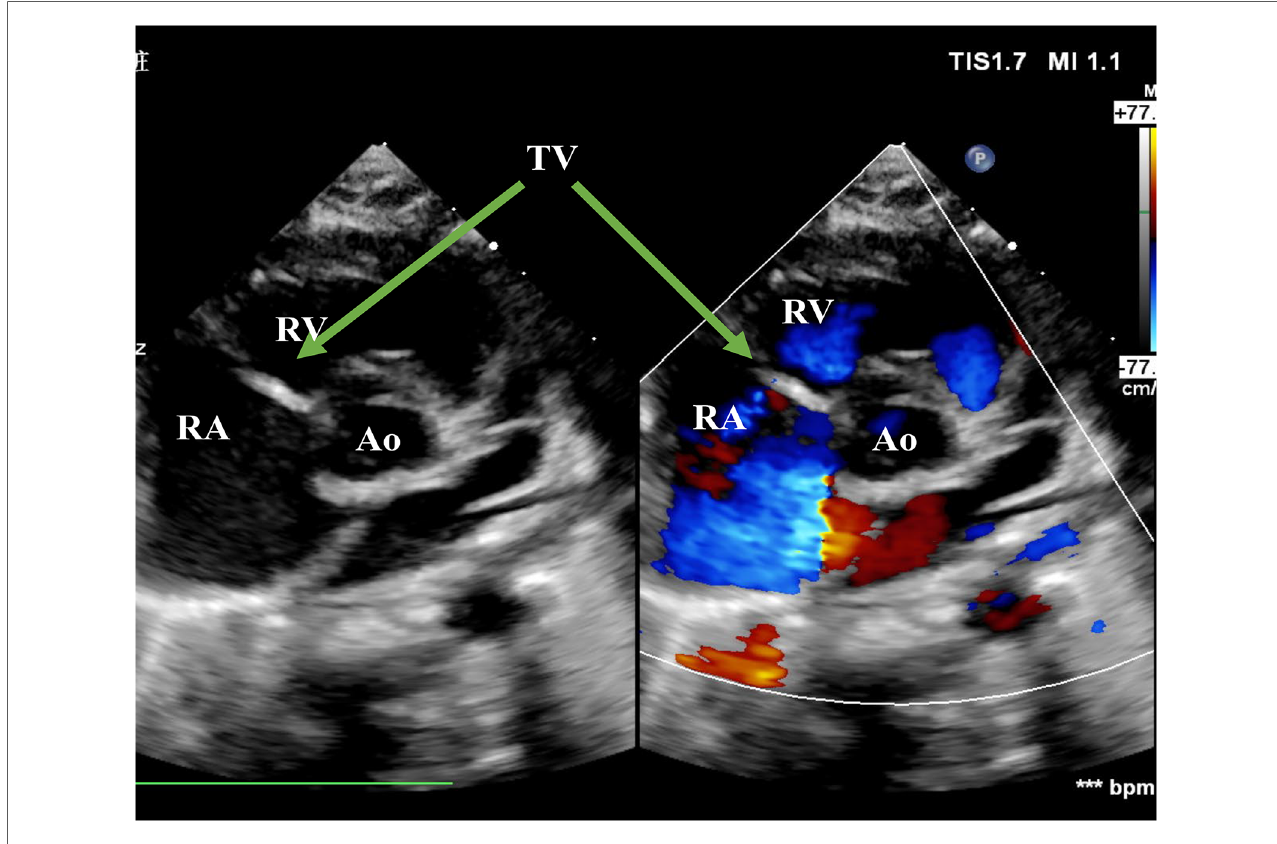
FIGURE 1 Echo before surgery in the PSAX view. The picture showed severe TR. RA, right atrium; RV, right ventricle; Ao, Aorta; TV, tricuspid valve; PSAX, parasternal short-axis view; TR, tricuspid